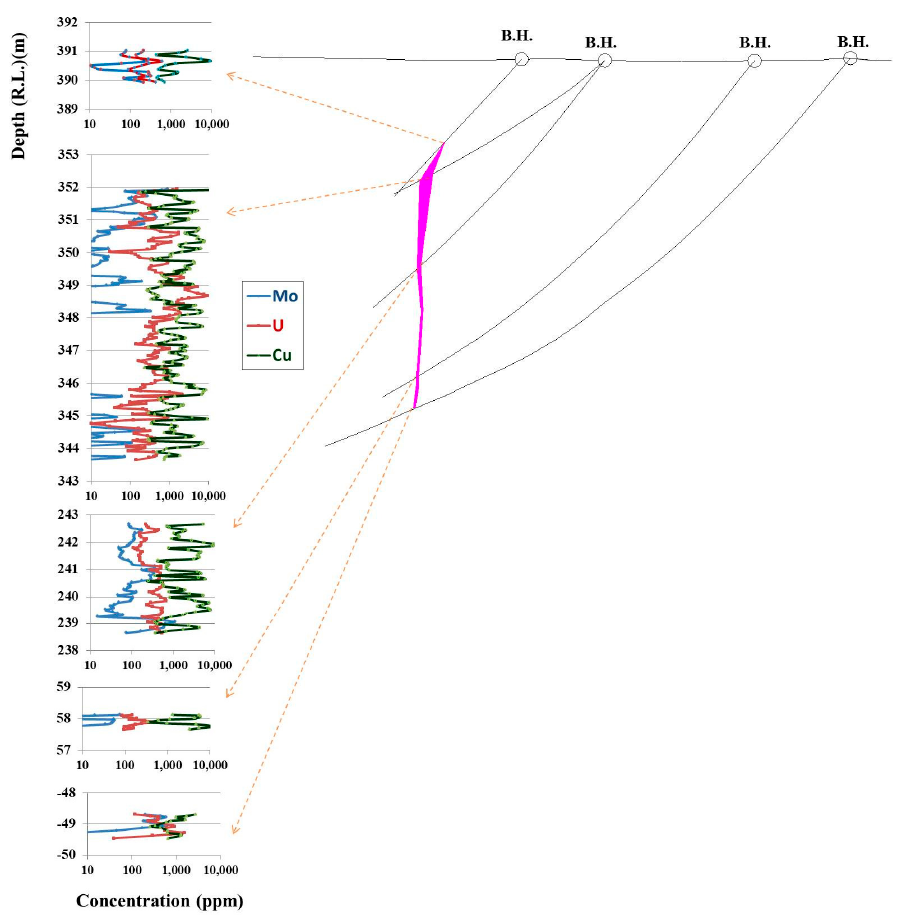
Figure 8. Elemental (U, Cu, and Mo) distribution and variation in concentration along the depth. The elemental concentration of uranium, copper, and molybdenum show high vari- ability with depth.